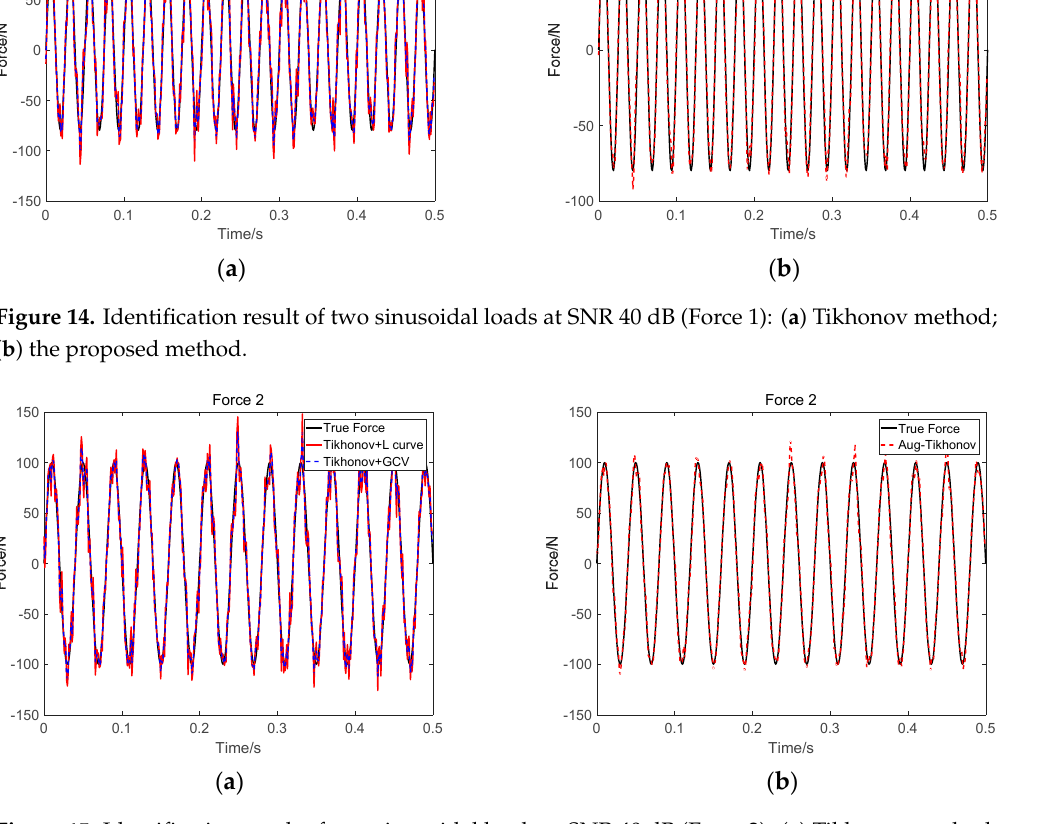
( b ) the proposed ( b ) the proposed method.